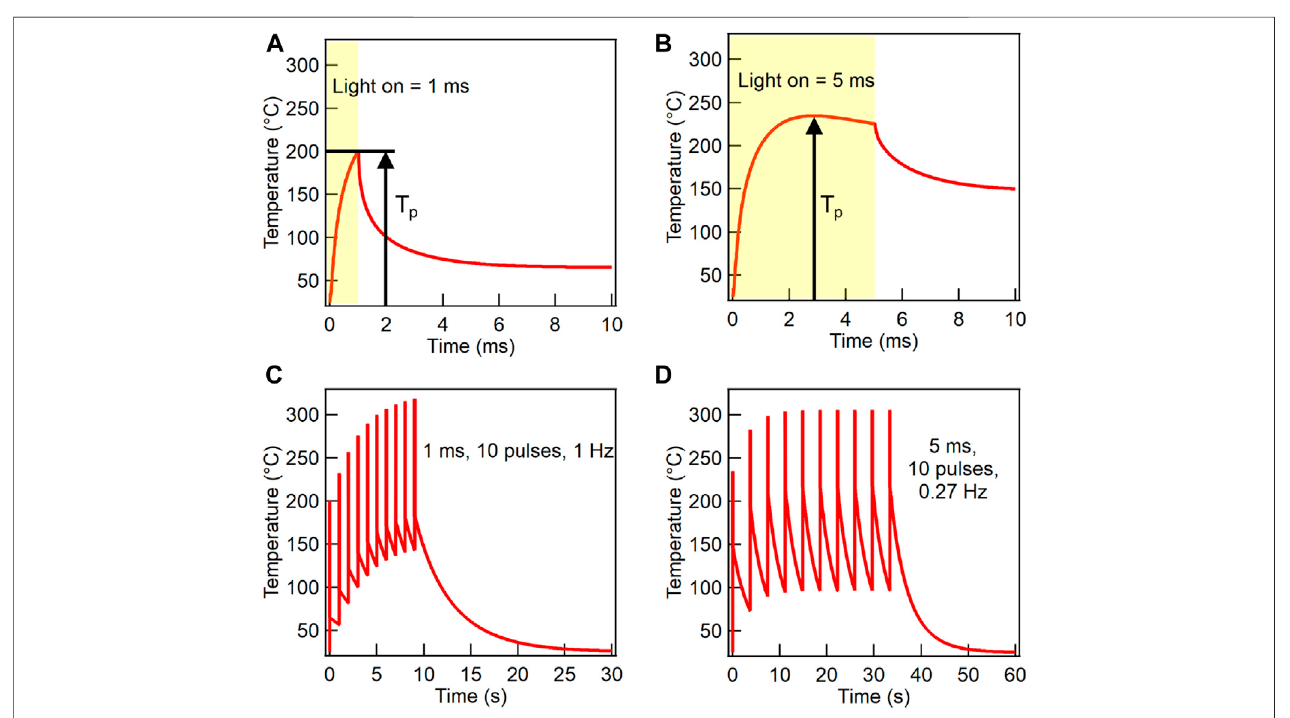
FIGURE 3 | SimPulse ® generated temperature at the top fi lm surface vs. time of a WG/ITO/NiO x -precursor stack during the photonic curing process for two differentpulselengthsandnumberofpulsesata fi xedlampvoltageof500 V: (A) Asingle1 mspulse. (B) Asingle5 mspulse. (C) Ten1 mspulseswitharepetitionrateof 1 Hz. (D) Ten 5 ms pulses with a repetition rate of 0.27